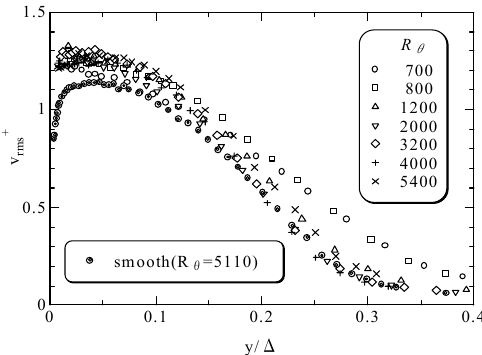
Fig.10 Similarity of the normal to the wall turbulent intensity profile normalized with the similarity